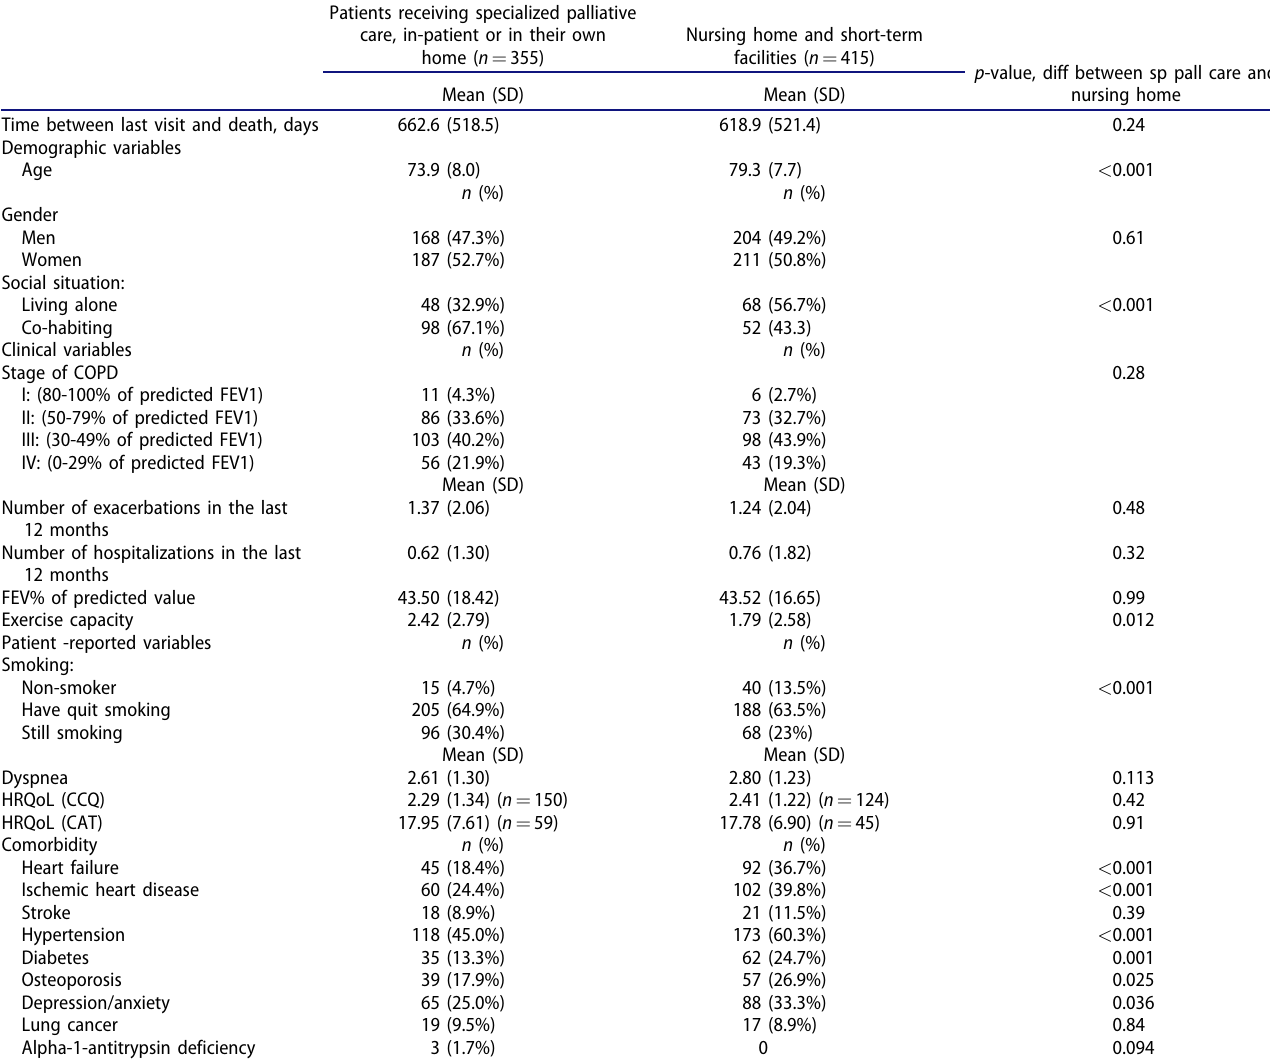
Table 1. Differences in patients who died in either specialized palliative care or in nursing homes ( n ¼ 770).